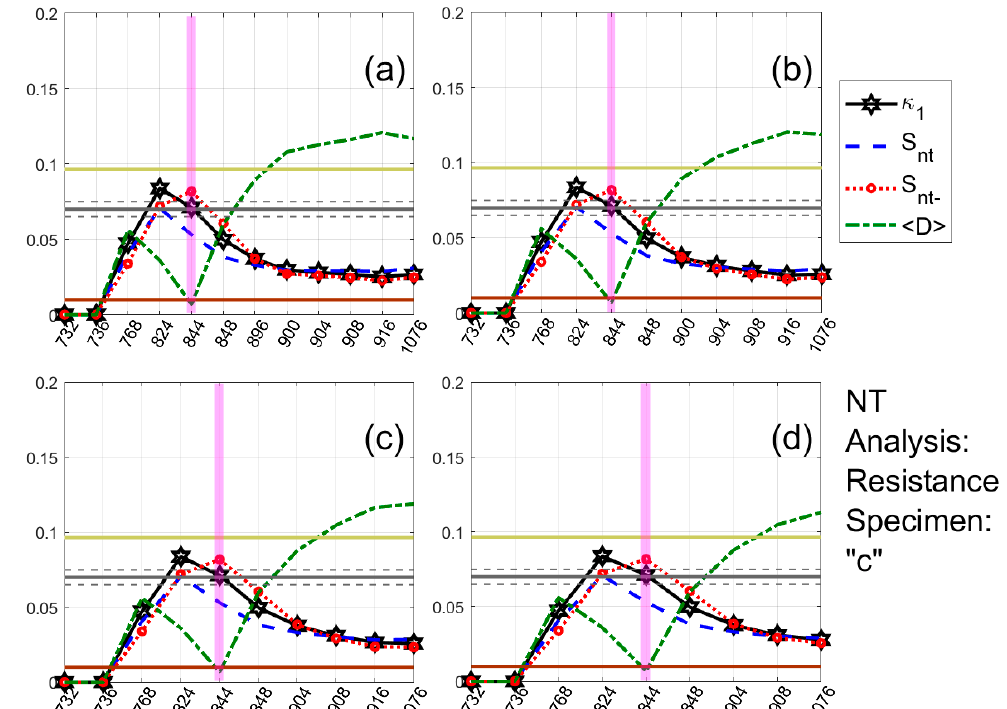
Figure 6. NT analysis of the electrical resistance time series acquired during the experiment involving specimen ( c ) of Figure 3. Variations of the NT analysis parameter values vs. time in seconds (0 s corresponds to the initiation of the experiment) for four di ff erent thresholds W Th : ( a ) 0.00825, ( b ) 0.00975, ( c ) 0.01 and ( d ) 0.0105. The format of this figure follows the format of Figure 5.